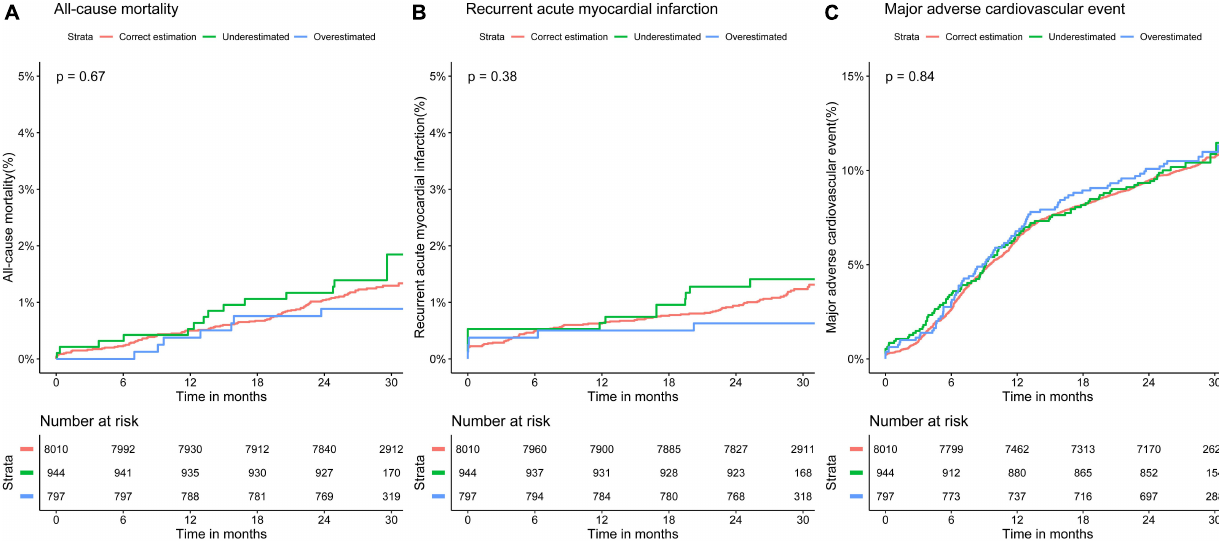
FIGURE 4 | Kaplan–Meier curves for 30-month adverse event rates in different classifications of low-density lipoprotein cholesterol by the Martin equation. Overall rates of (A) all-cause mortality, (B) recurrent acute myocardial infarction, and (C) major adverse cardiovascular event.